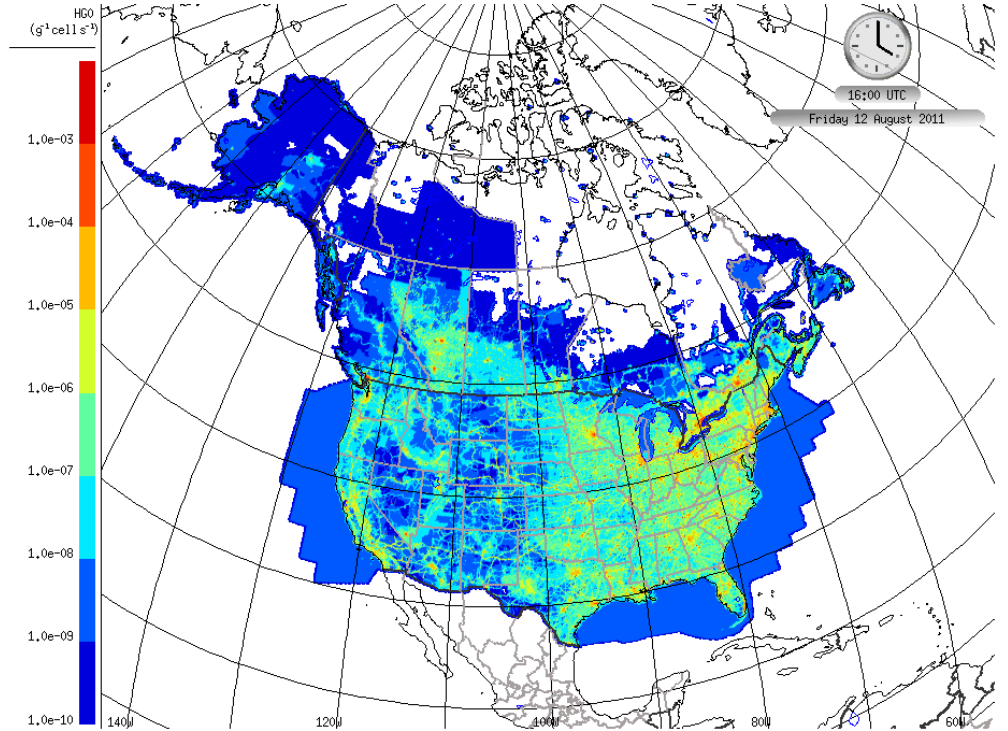
Figure 12. Spatial distribution of phase 3 elemental mercury emissions for Canada and the United States for the 10km continental model grid for 1h in the afternoon in August. Note logarithmic spacing of the emissions contour intervals; white areas have emissions less than 10 − 10 gcell − 1 s − 1